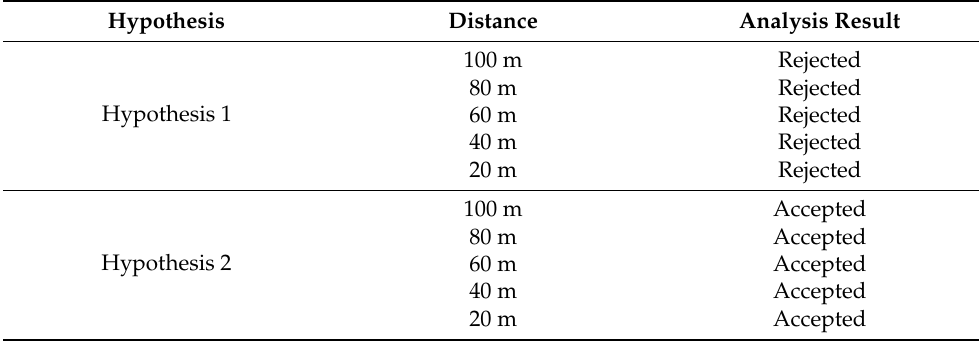
Table 7. Result of ANOVA test on the effect of materials and speed on the intensity for each distance. Hypothesis Distance Analysis Result